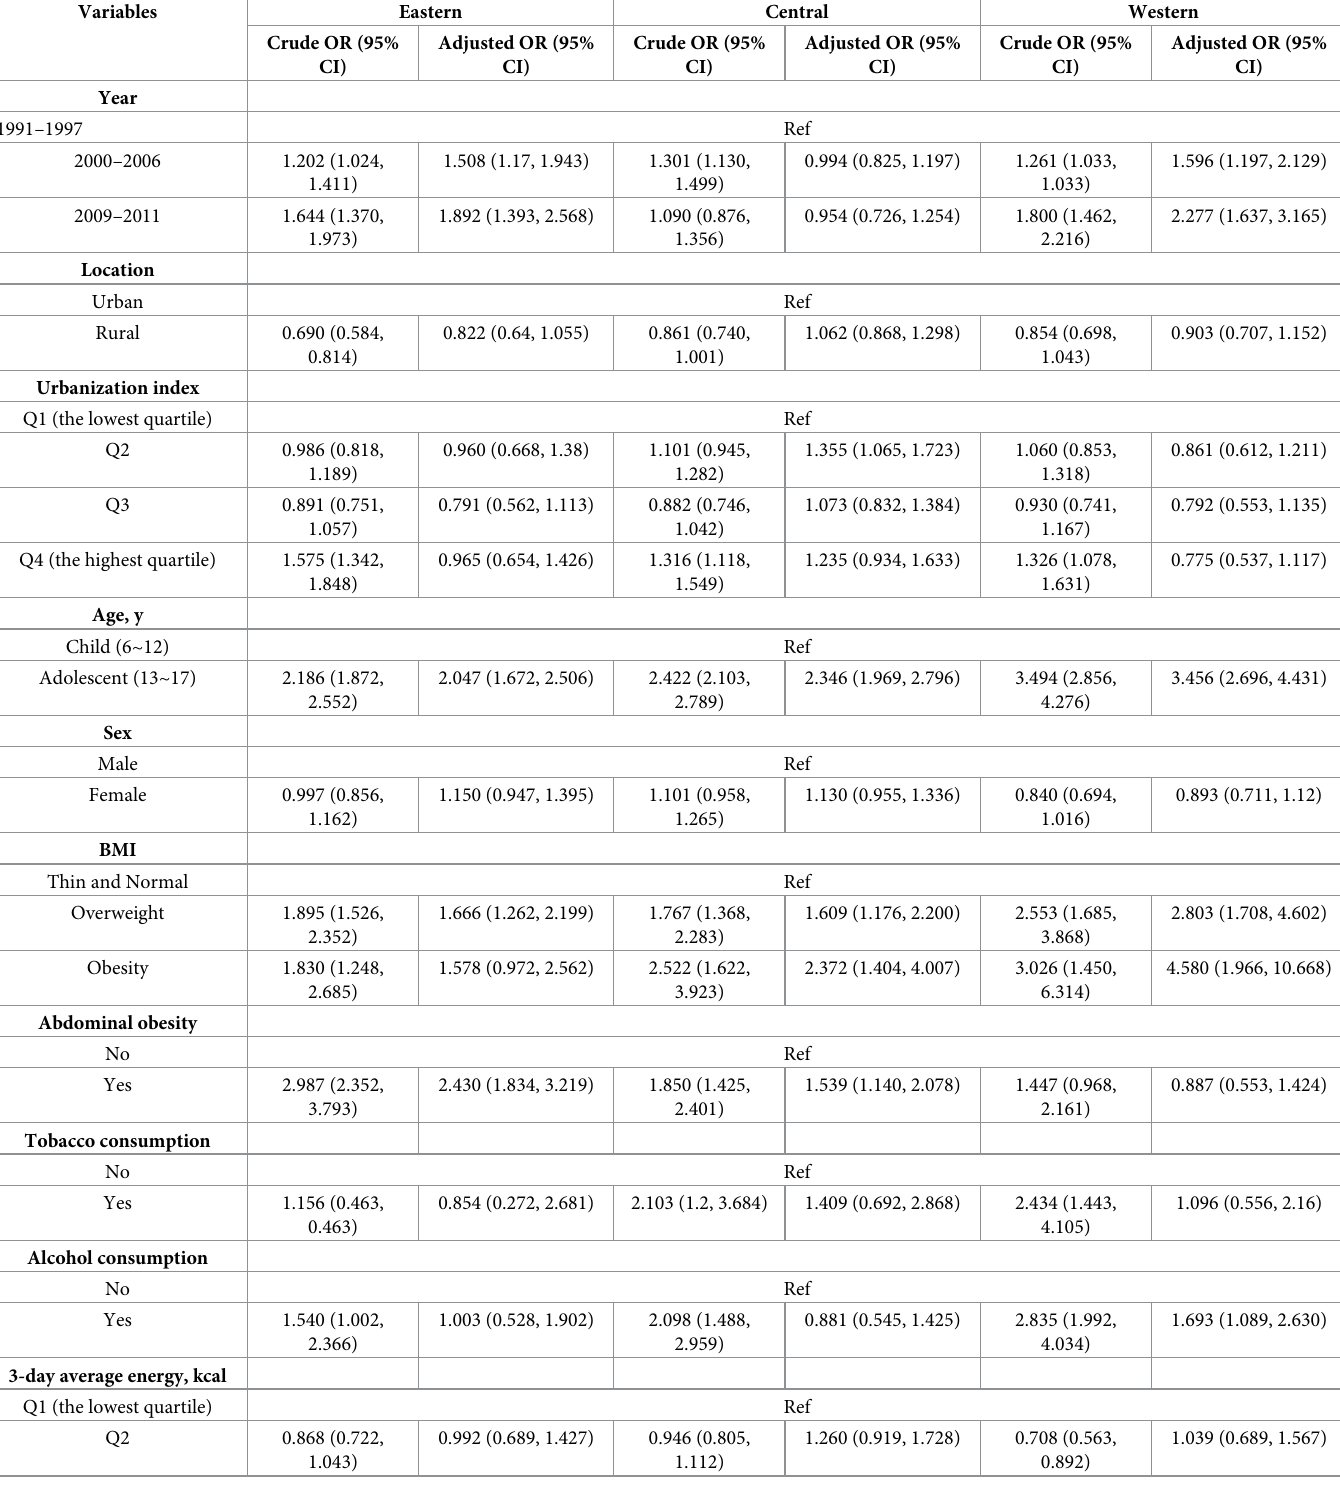
Table 3. Factors associated with prehypertension and hypertension in three